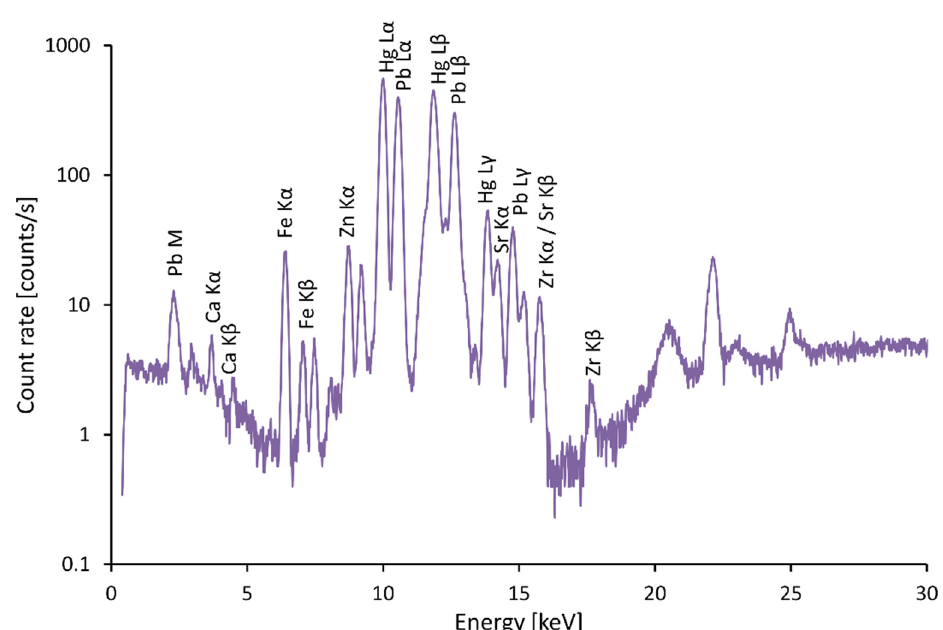
Figure 4. Spectrum of red lead.